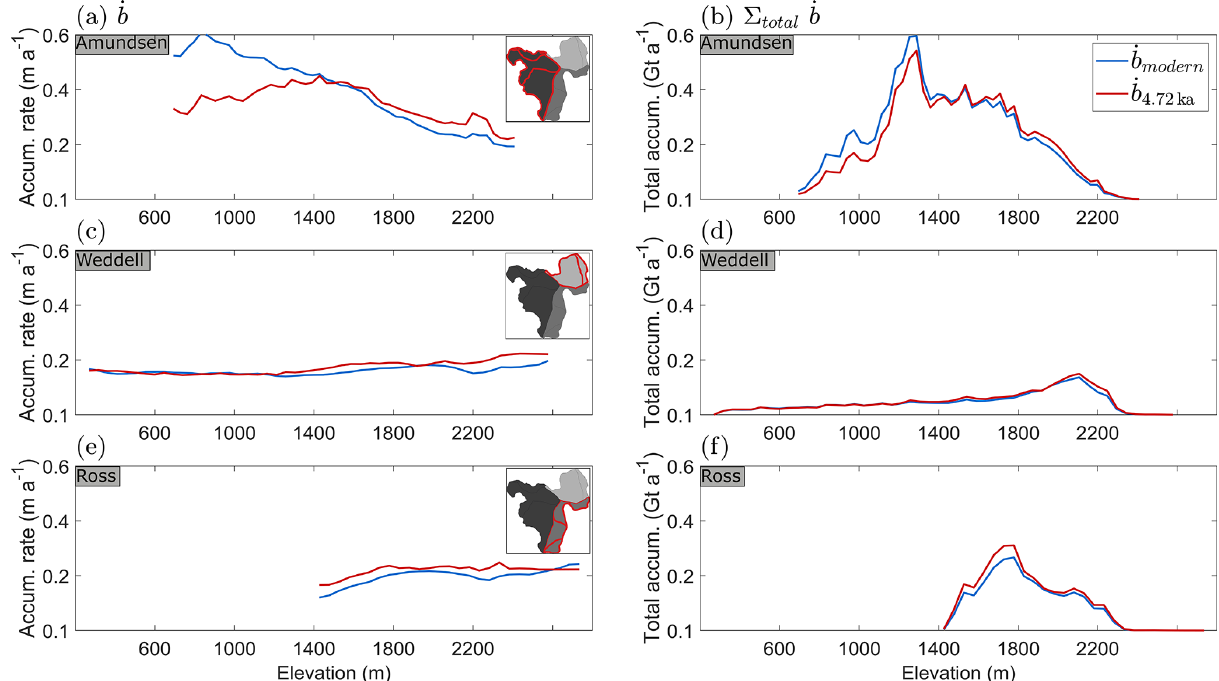
Figure 5. Comparison of ice-equivalent accumulation rates between the 4.72ka-to-present estimates and modern rates (RACMO2) binned by 50m elevation bands across the three main catchments considered here (Amundsen, Weddell, and Ross). (a, c, e) Mean accumulation rate averaged per 50m elevation band across the specific catchment area in metres per annum (ma − 1 ). (b, d, f) Total accumulation rate per 50m elevation band across the specific catchment area in gigatonnes per annum (Gta − 1